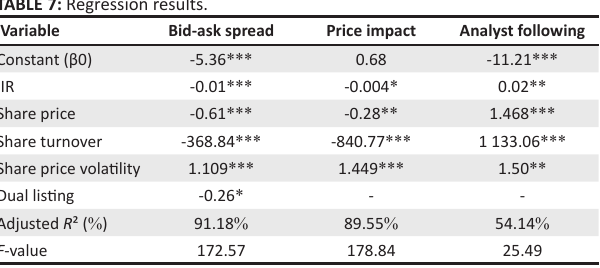
TABLE 7: Regression